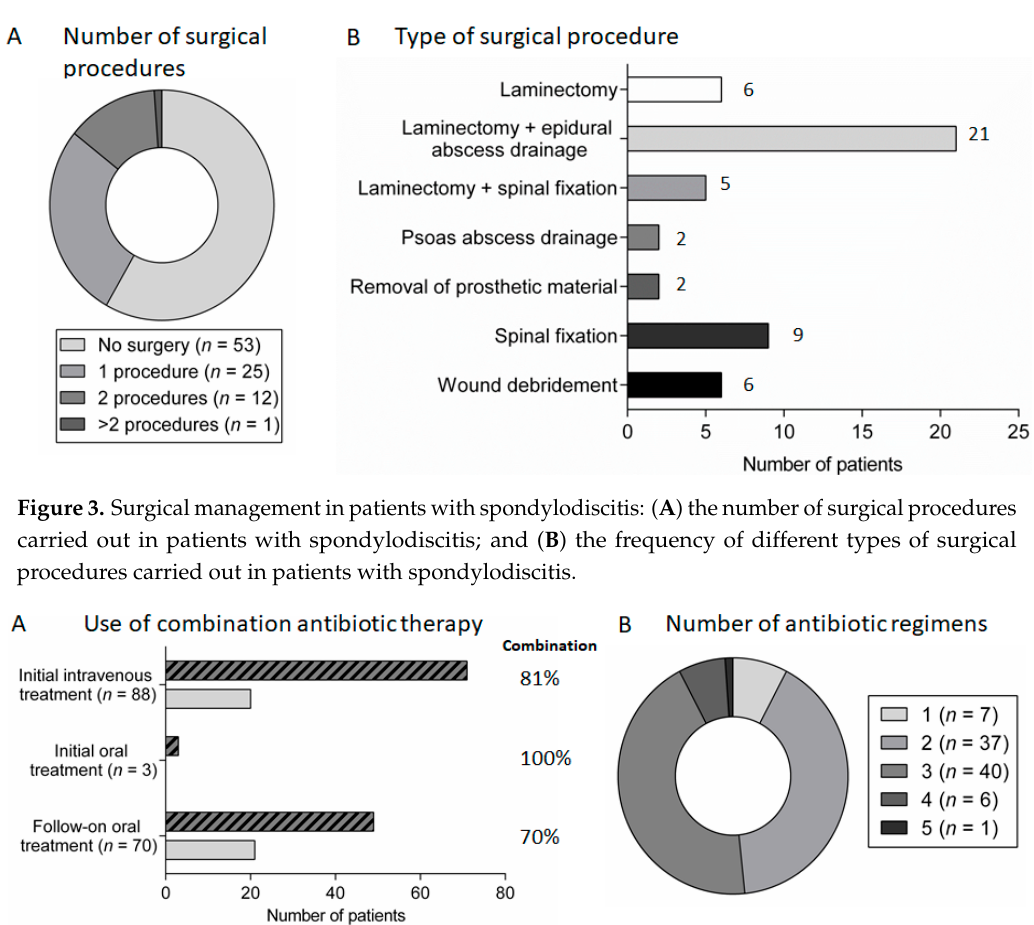
patients, 98%). In most cases, this consisted of an initial intravenous antibiotic-containing regimen